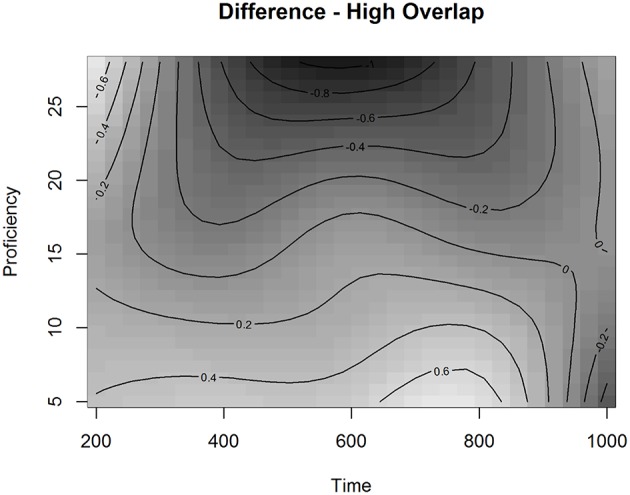
Partial effect of the Difference surface for high Orthographic Overlap as a function of Time and Proficiency in Experiment 2 in the L2 group.